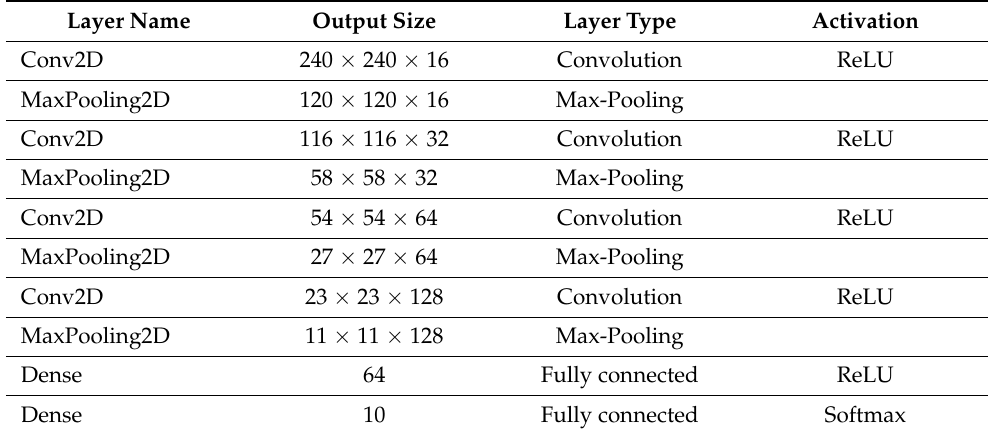
Figure 14. Accuracy ( a ) and loss ( b ) in relation to the number of iterations (epochs).